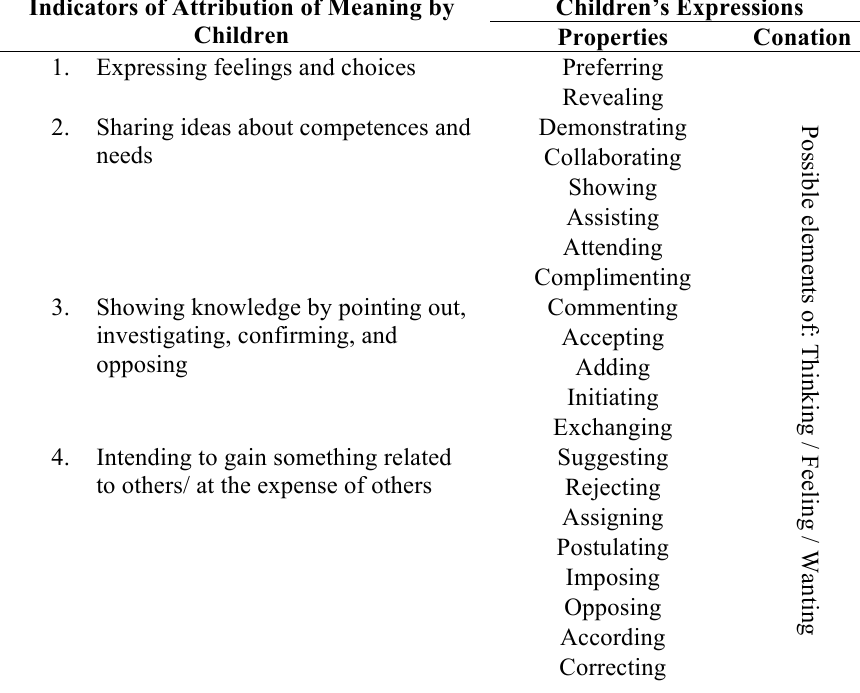
Indicators of Attribution of Meaning, Related to Characterizations of Children’s Expressions (Properties With Possible Elements of Conation: Thinking, Feeling, Wanting)